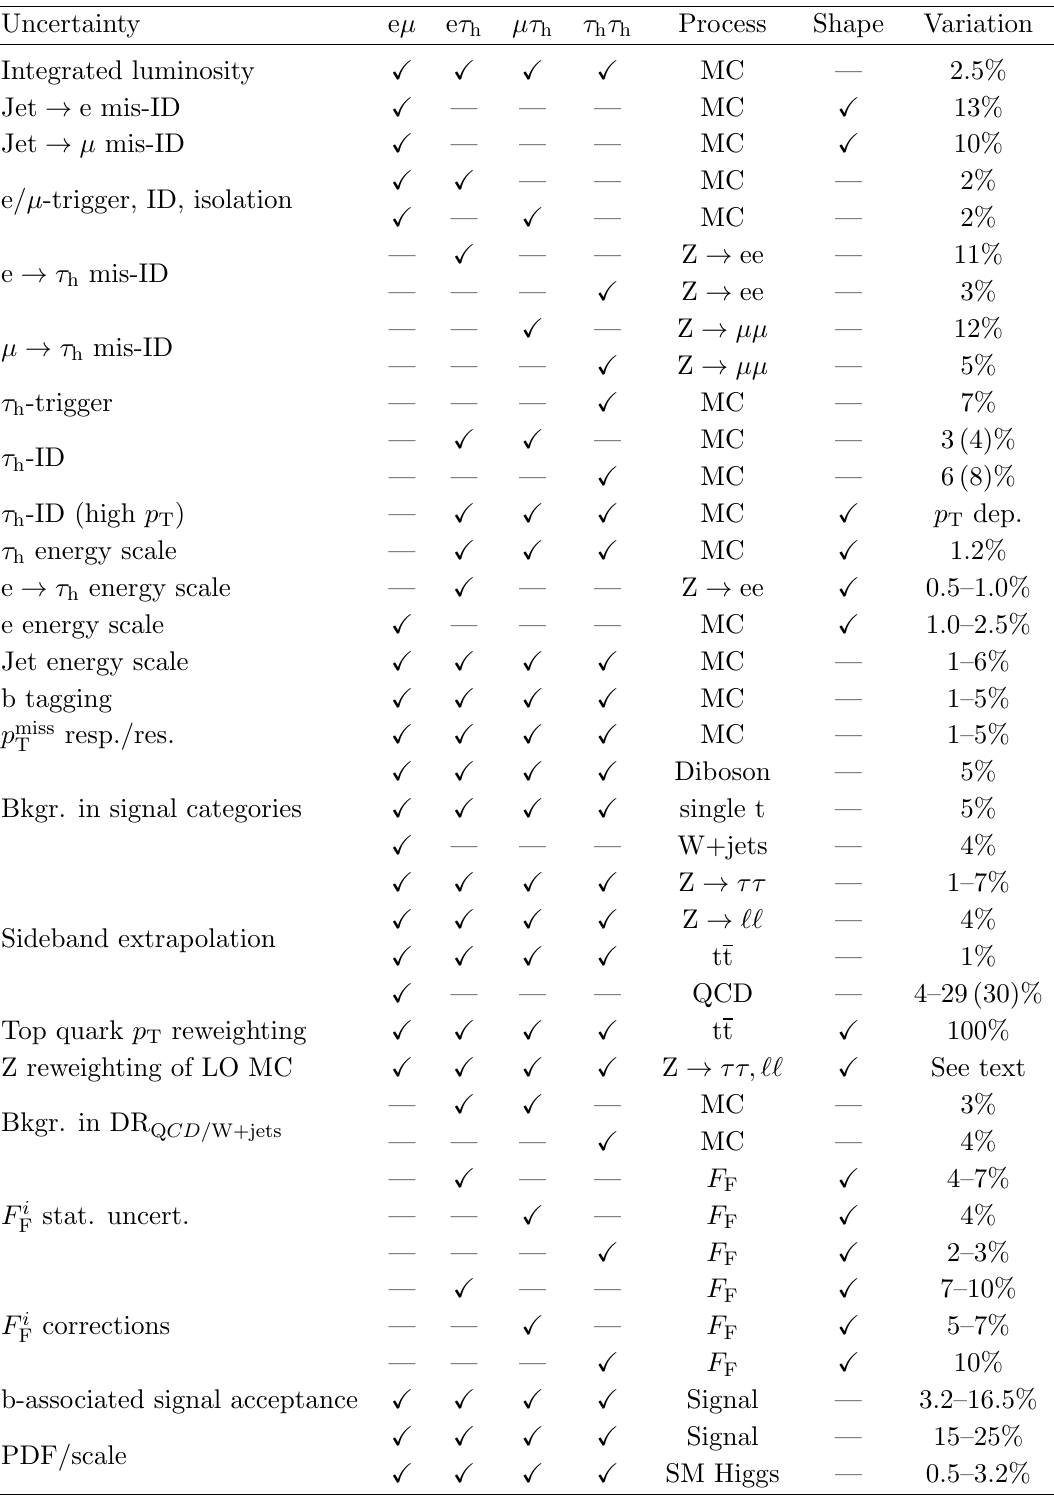
Table 5 . Overview of the systematic uncertainties used in the likelihood model for the statistical inference of the signal. The label \MC" refers to all processes that are obtained from simulation, the label \ F F " refers to all backgrounds that are obtained from the fake factor method. Values in parentheses correspond to additional uncertainties correlated across (cid:12)nal states or event categories. Detailed descriptions are given in section